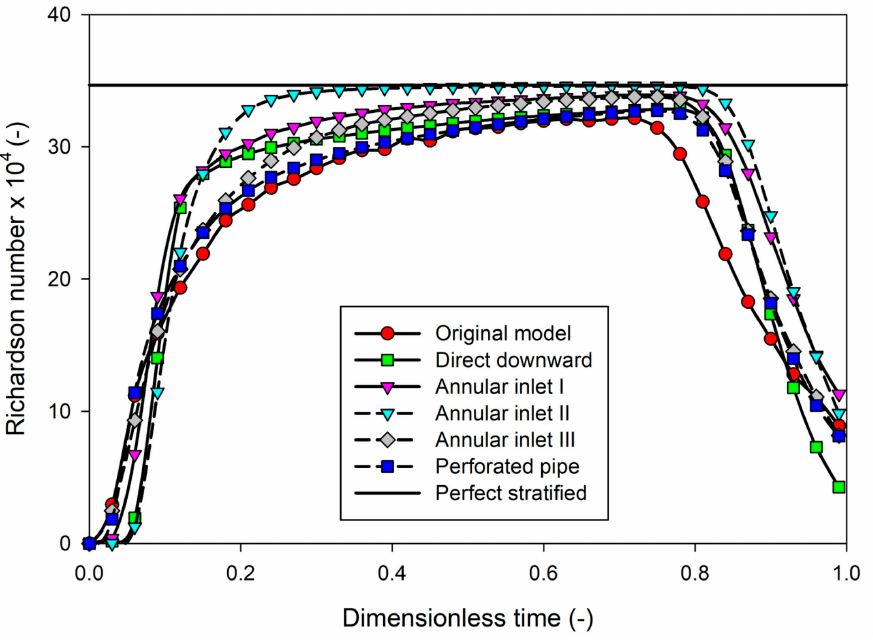
Figure 8. The Richardson numbers of the modified inlet pipe